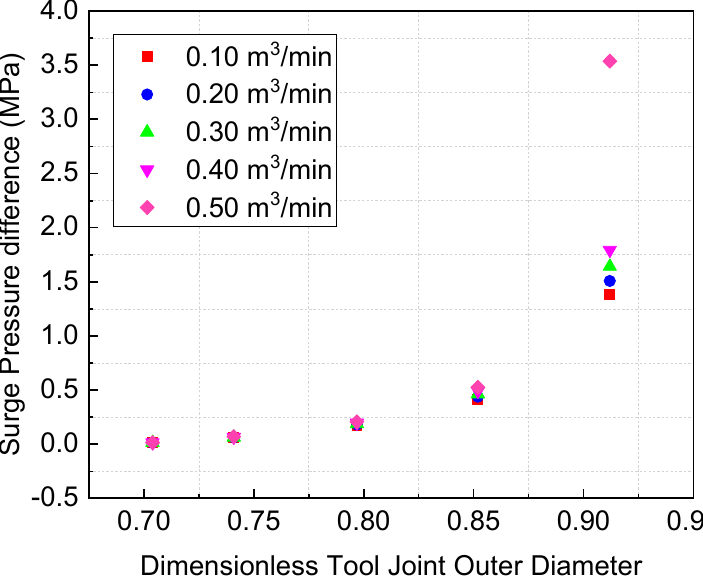
Figure 16. The difference between the surge pressure when the tool joint is considered and the surge pressure when the joint is not considered.